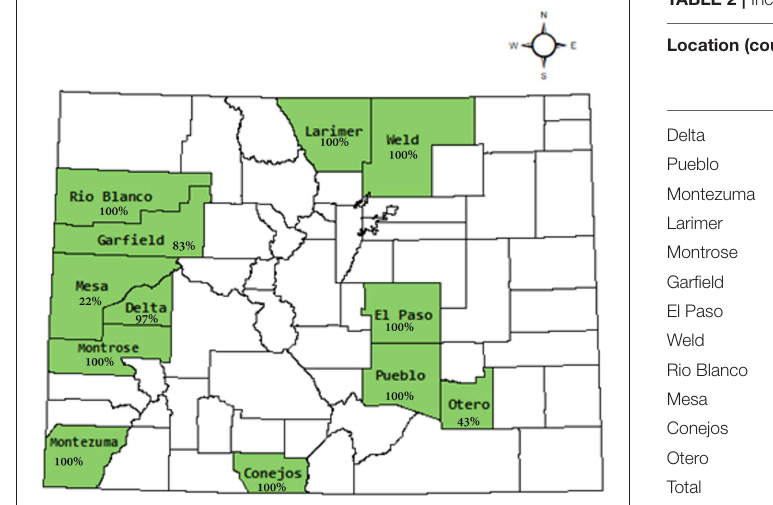
TABLE 2 | Incidence of BCTV strains associated with hemp in